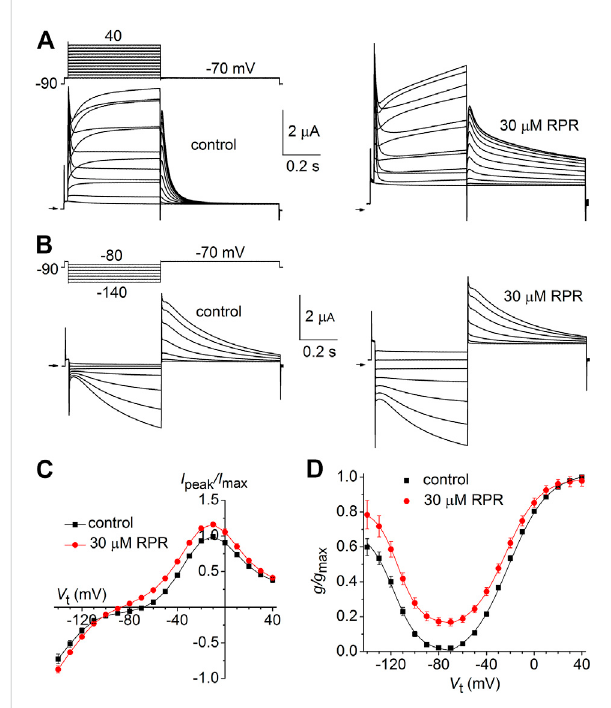
FIGURE 6 Effects of RPR on D540K hERG1a channel currents. (A) Voltage clamp protocol and corresponding currents recorded at a V t ranging from − 70 mV to 40 mV from an oocyte before (control) and after treatment with 30 µM RPR. Small horizontal arrows indicate zero current level. (B) Voltage clamp protocol and corresponding currents recorded at a V t ranging from − 80 mV to − 140 mV from a single oocyte before(control)andaftertreatmentwith30 µMRPR. (C) I-V relationships for 0.5 s test pulses ( n = 10; p < 0.001, 2-way ANOVA). (D) Effect of RPR on the G - V relationship ( n = 10). For control, V 0.5 = − 118 ± 3 mV ( k = 10.6±1.1)and − 24.7±4 mV( k =7.2±1.0).For30 µMRPR, V 0.5 = − 114± 0.5 mV ( k = 9.2 ± 0.3) and − 23.9 ± 0.4 mV ( k = 14.2 ±